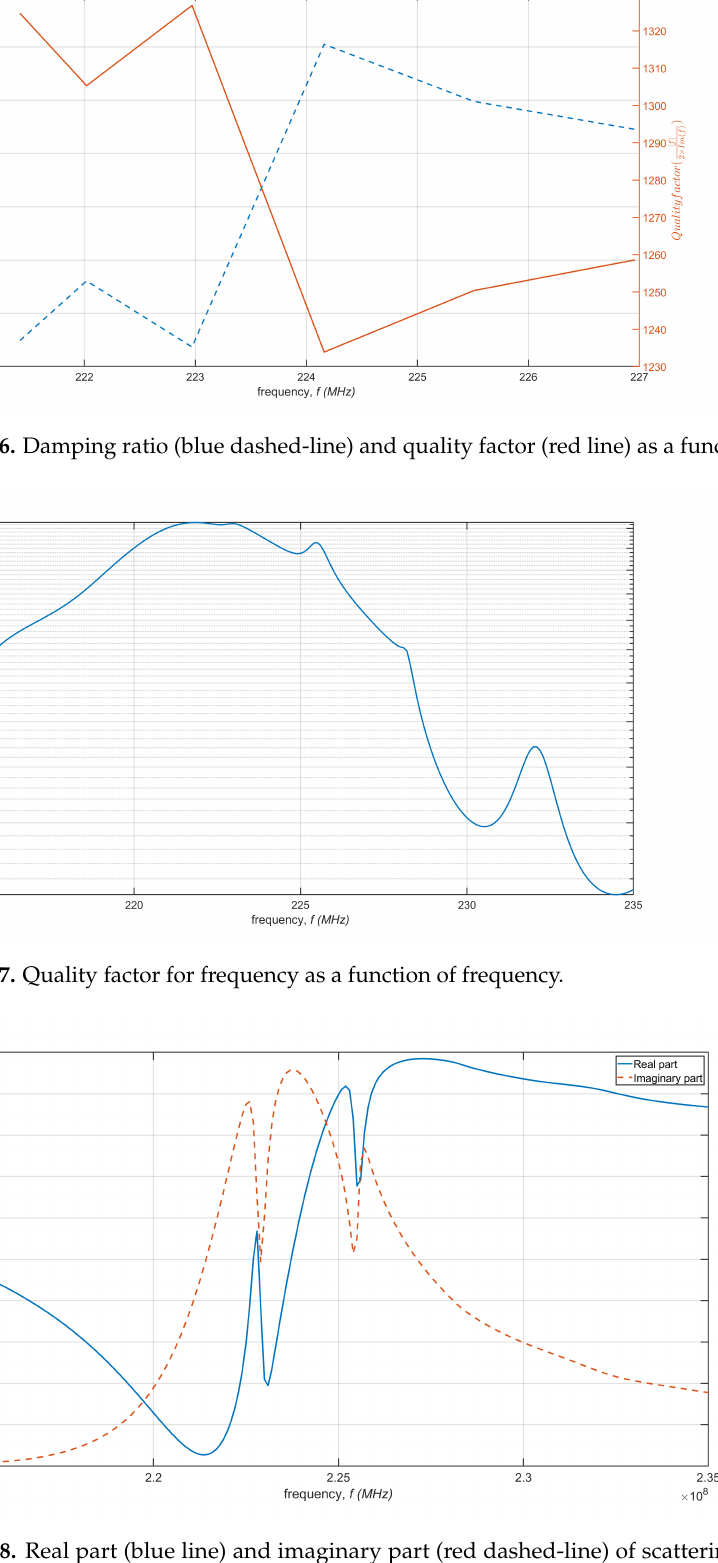
Figure 18. Real part (blue line) and imaginary part (red dashed-line) of scattering parameter as a function of